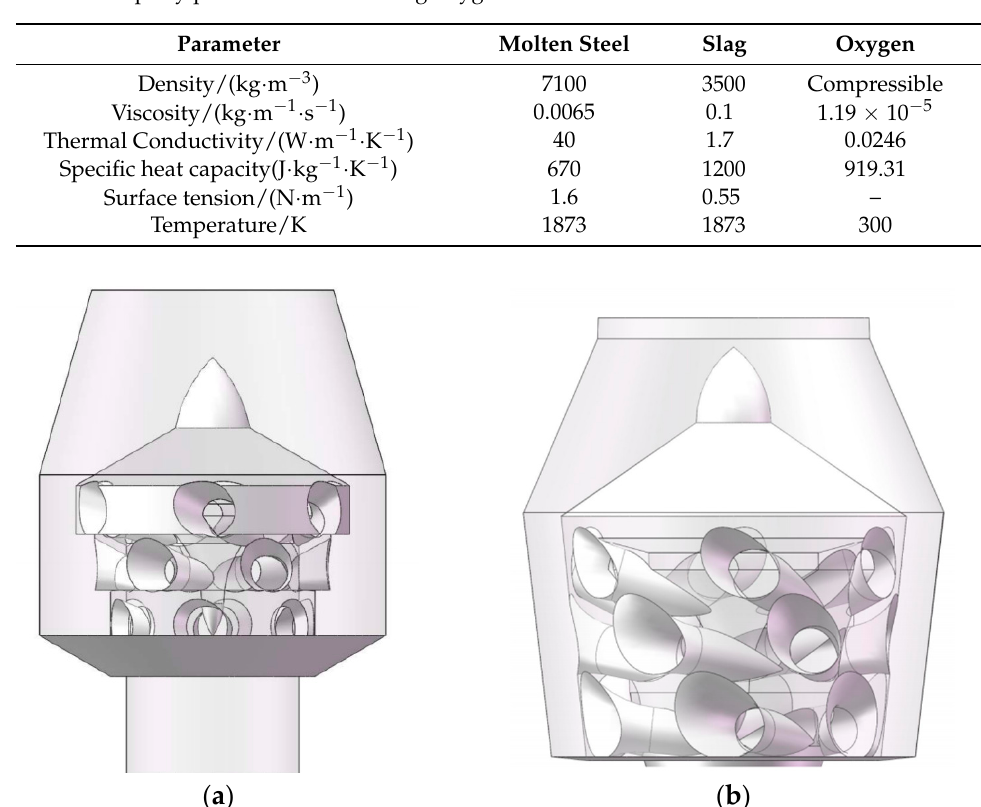
Table 2. Property parameters of steel-slag-oxygen.